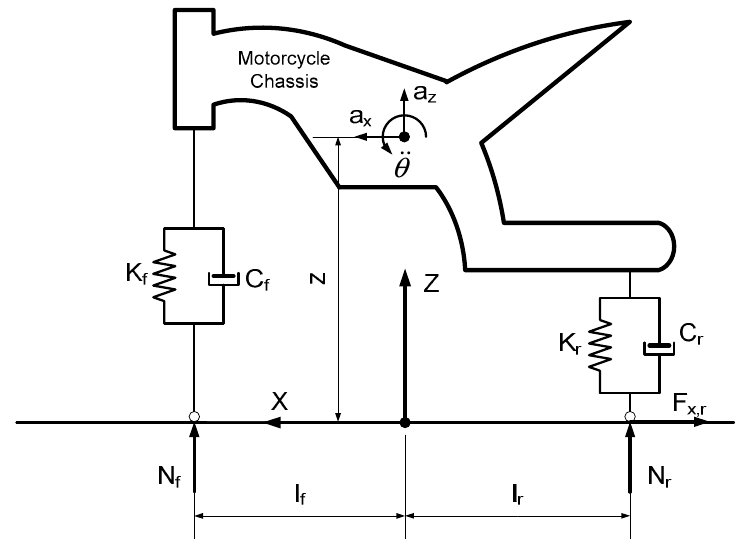
Figure 4. Simplified motorcycle model. Table 1. Motorcycle model parameters.